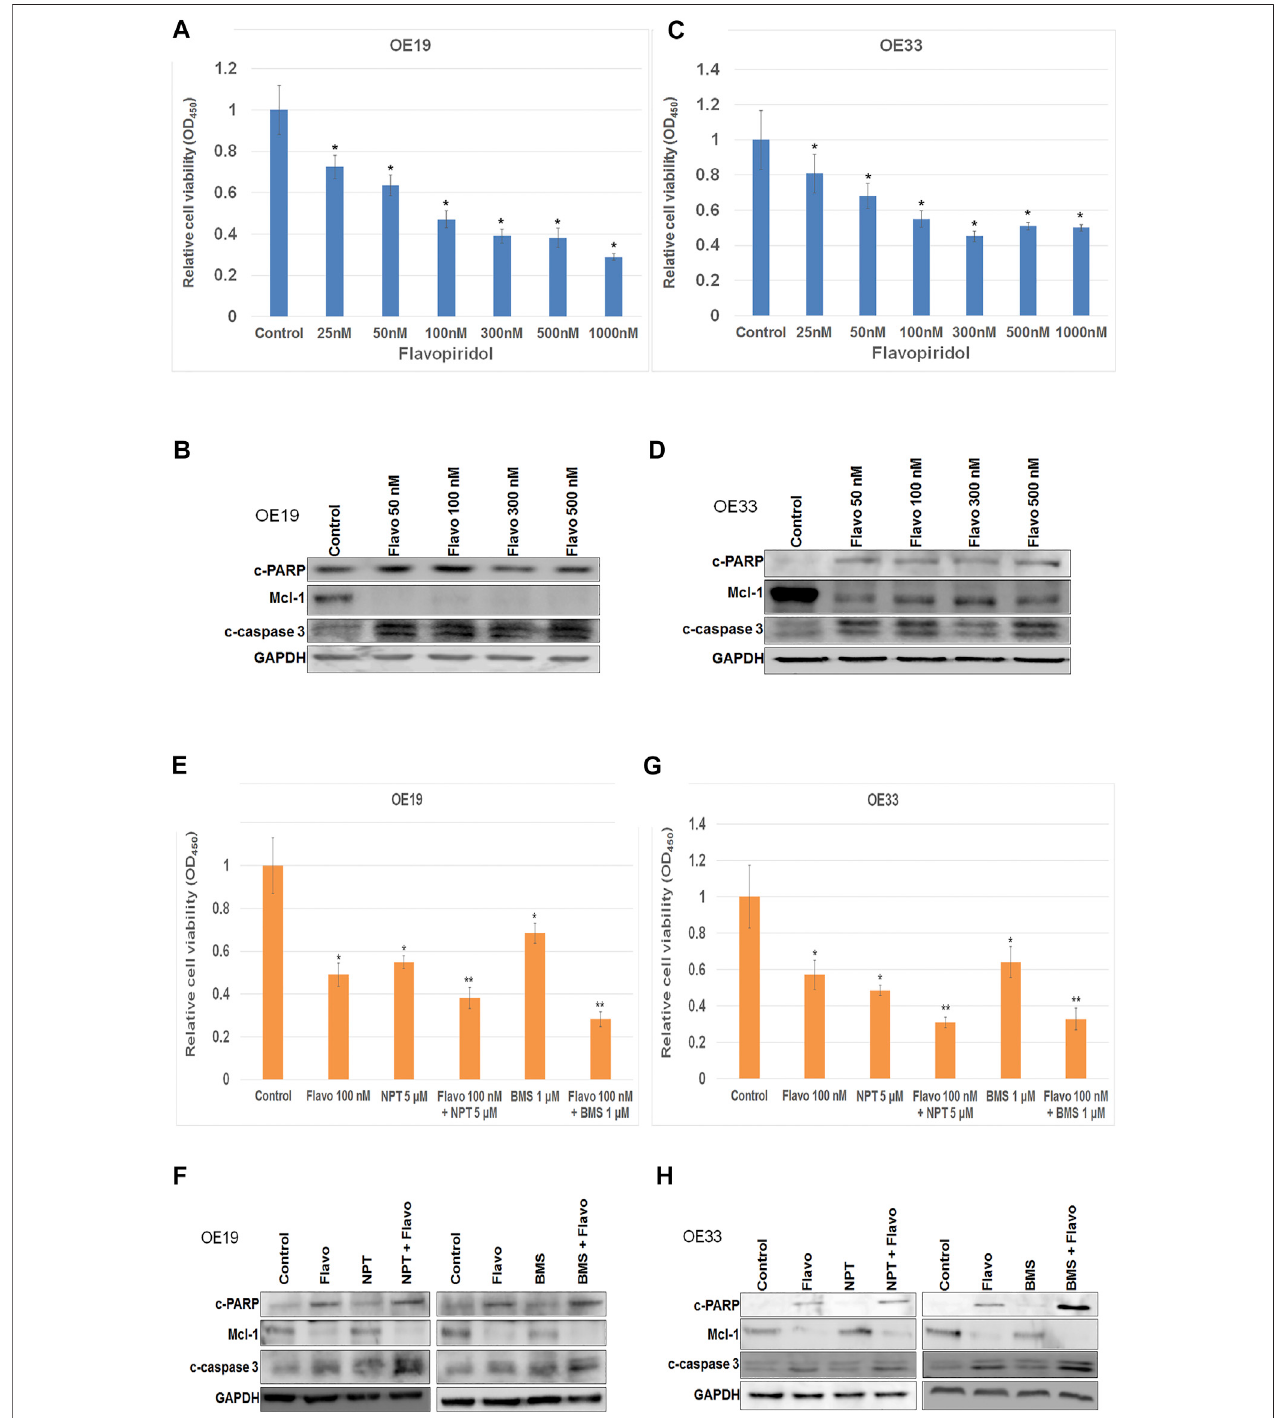
FIGURE 3 | Flavopiridol alone or in combinations induced cell death in c-Myc expressing EC cell. (A – D) Nanomolar concentrations of Flavopiridol induced high c-Myc expressing (A,B) OE19 and (C and D) OE33 cell death. (E – H) Flavopiridol showed enhancement of high c-Myc expressing (E,F) OE19 and (G and H) OE33 cell death when it combined with chemotherapeutic agent nanoparticle albumin-bound paclitaxel (NPT) or IGF-1R/IR targeted agent BMS-754807 (BMS). For (A,C,E,G) WST-1assay (A,C) OE19and (E,G) OE33ECcellswereplatedon96-wellplatesandtreatedwith (A,C) 25 – 1,000 nMconcentrationsof fl avopiridol, (E,G) 100 nM of fl avopiridol alone and in combinations with 5 µM of NPT or 1 µM of BMS. After 72 h, the number of viable cells was calculated by WST-1 assay. Data are the mean ± SDE of six determinations. * represents fl avopiridol treatments are signi fi cantly different from the control and ** represents Flavo + NPT or Flavo + BMS treatments are signi fi cantlydifferent from themonotherapy.In (B,D,F,H) western blotscell lysates were analyzed with antibodies tocleaved PARP (c-PARP), Mcl-1, cleaved caspase-3 (c-caspase 3) and GAPDH. Data are representative of three independent experiments with similar results.